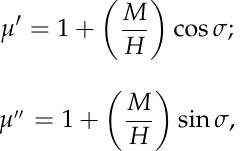
Figure 7. Plots of 𝜇 ′′ (𝜇 ′ ) −2 𝑓 −1 vs. frequency for all the as-prepared magnetic wood fibers.